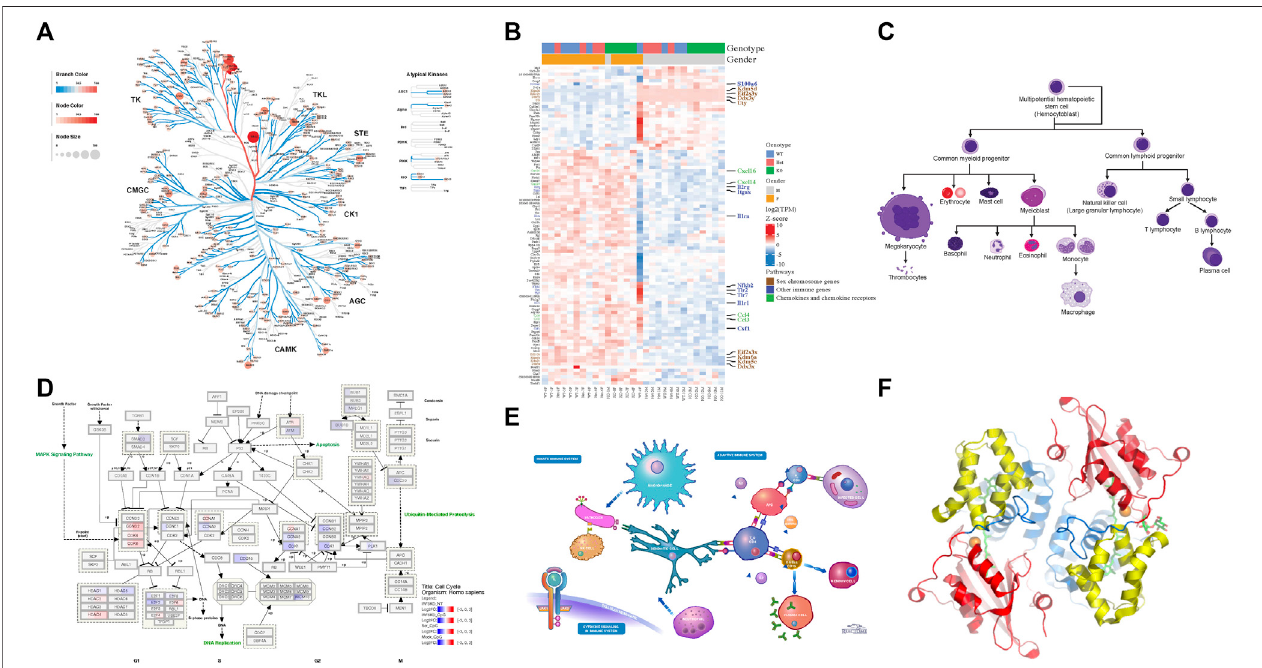
FIGURE 1 | High-resolution plots generated by various tools are arranged by the online tool, bioInfograph, to produce a composite plot. Unless speci fi ed, the source plot is in Scalable Vector Graphics (SVG) format. (A) Human kinome tree generated by Coral web app. (B) Gene expression heatmap by R package ComplexHeatmap. (C) Blood cell lineage from Wikimedia Commons (https://bit.ly/2Wjc5aS). (D) Human cell cycle pathway diagram from WikiPathways. (E) Human immunesystemillustrationfromReactome. (F) Protein3Dstructure ribbonforminpngformatbyPyMOL(DeLano, 2000).Aninteractiveversionofthe fi gureforthe enlarged view of individual panels is available at